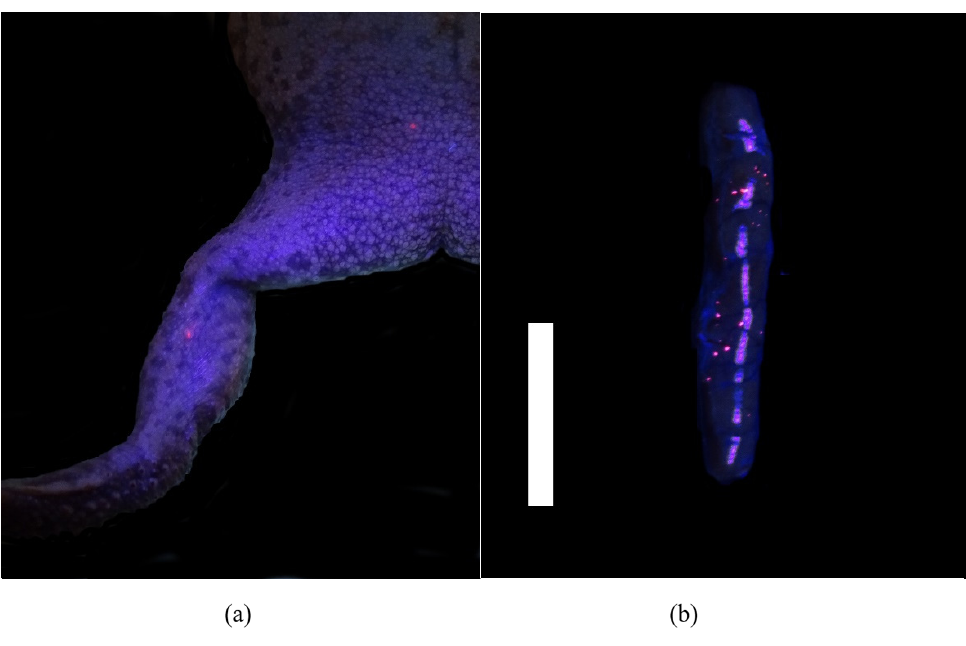
Figure 1. Gross postmortem examination of a marine toad ( Rhinella marina ) under UV light 9 days after visible implant elastomer (VIE) tag placement in the right distal limb. ( a ) Pinpoint fluorescent pink VIE is visible at the site of insertion under the skin over the right gastrocnemius muscle and migrated to the right inguinal region. ( b ) Multifocal pinpoint pink fluorescence throughout the parenchyma of the kidney, indicating systemic migration of VIE (white bar = 1